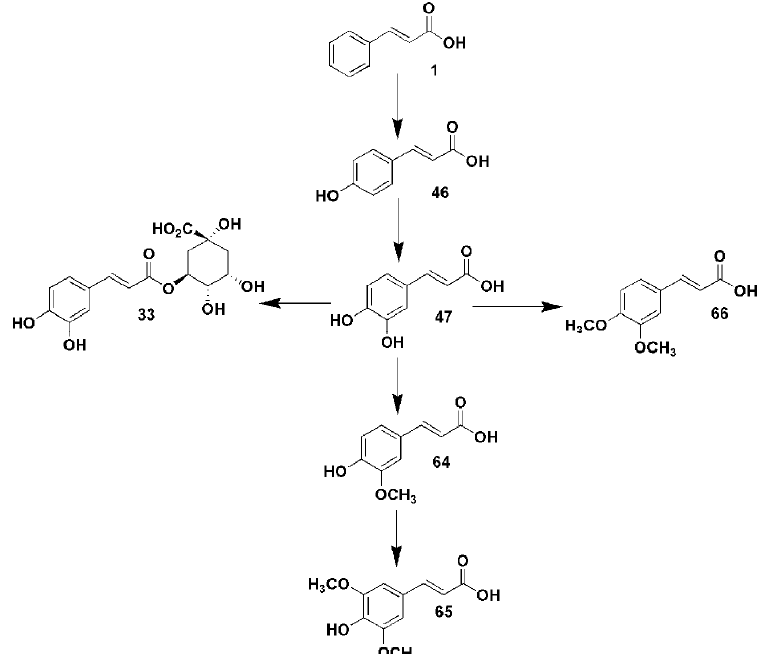
Figure 18. Chemical structures of cinnamic acid with in vitro anthelmintic (AH) activity